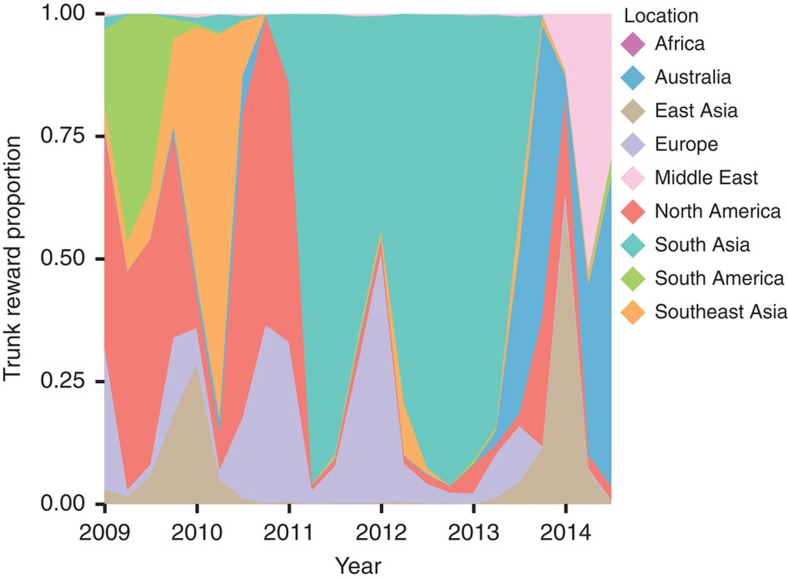
Proportional ancestral location states on the phylogenetic tree trunk estimated for each location over time.The waiting time between geographic location transitions was inferred using the continuous-time Markov chain model. The trunk reward proportion for each geographic location from 2009 through 2014 was determined from an analysis of 2,225 HA sequences of H1N1/2009 viruses. Shaded areas represent the trunk proportions over time for the nine geographical locations included in the analysis.